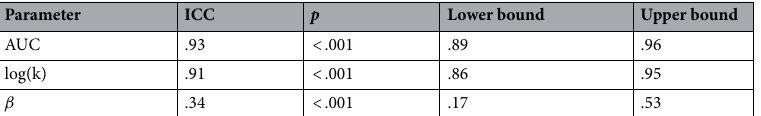
Table 3. Summary of the results of the ICC analysis for the AUC values as well as the two parameters of the hyperbolic discounting model with a softmax choice rule. Lower and upper bound describe the 95% confidence interval.